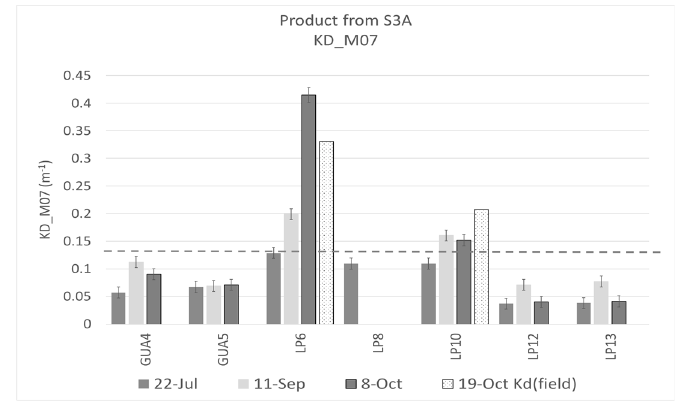
Figure 7. K d 490 product from Sentinel 3A for 22 July, 11 September, and 8 October 2017. The figure includes the K d 490 nm field data on 19 October 2017 at LP6 sampling site. The dashed line represents the second standard deviation (2SD) for K d 490 field data.